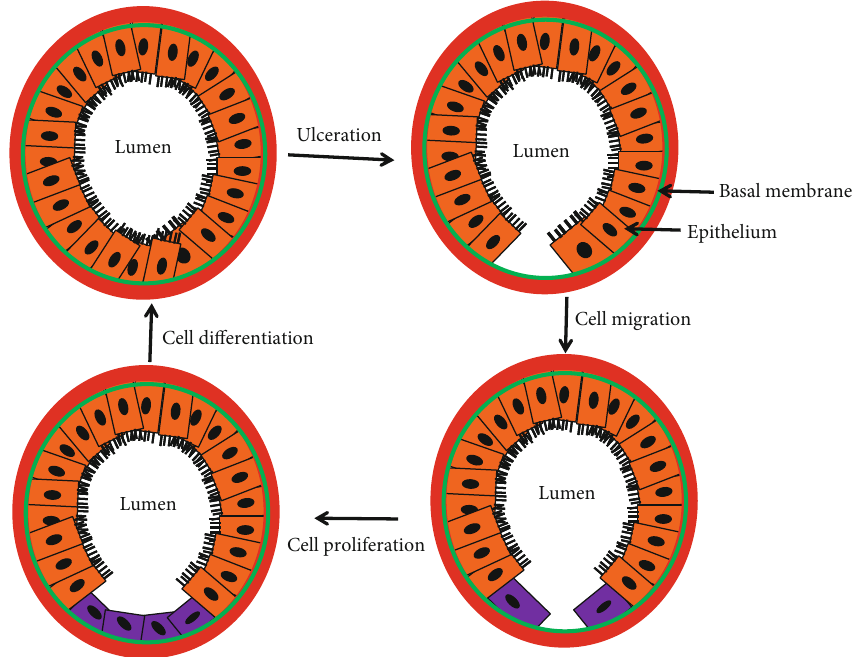
Figure 1: Schematic diagram for the cellular processes involved in intestinal